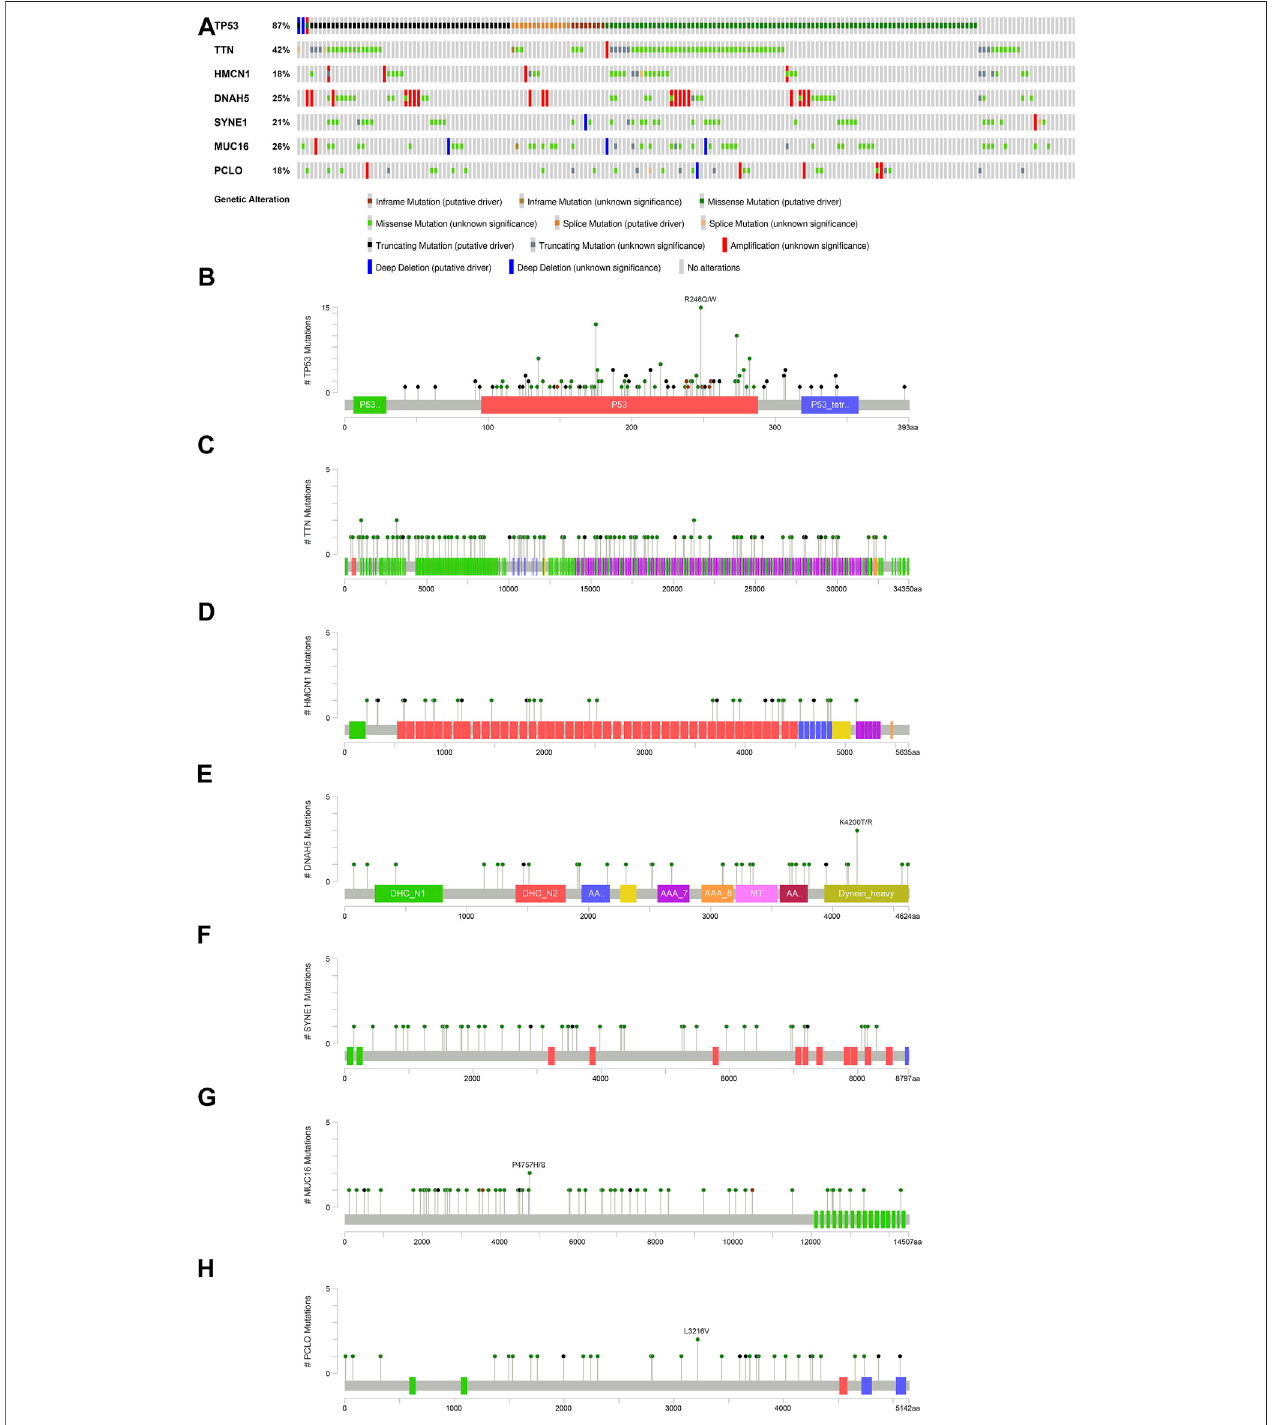
FIGURE7| OverviewofthesevenmostcommonmutantgenesinEACpatients. (A) Proportionand mutationtypeofgenes.Differentcolorbarsrepresentdifferent mutational types. (B) TP53-speci fi c mutation site. (C) TTN-speci fi c mutation site. (D) HMCN1-speci fi c mutation site. (E) DNAH5-speci fi c mutation site. (F) SYNE1- speci fi c mutation site. (G) MUC16-speci fi c mutation site. (H) PCLO-speci fi c mutation site.